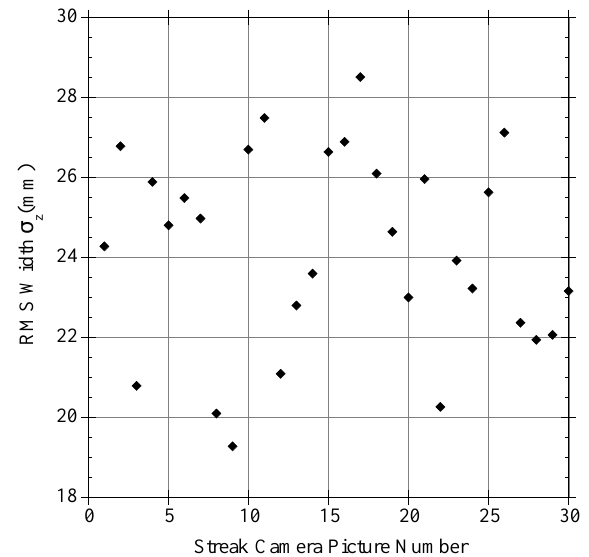
FIG. 15. The bunch length as a function of picture number taken by the streak camera when modulating the rf voltage at a voltage amplitude of 1 10 dBm and frequency of 369.9 kHz.